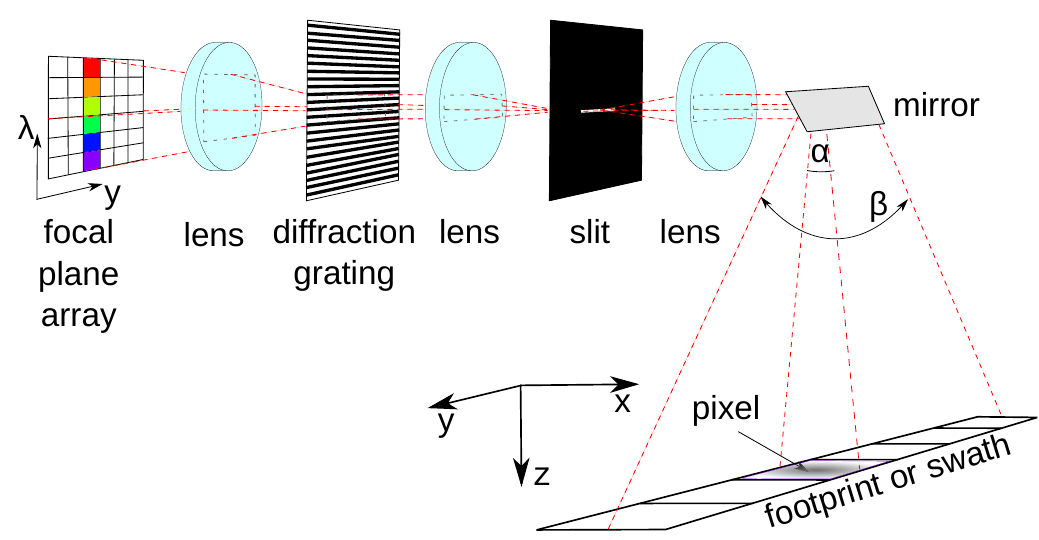
Figure 1: Working principle of a pushbroom sensor: The spectrum of the Gray shaded pixel is mapped to the coloured column on the focal plane array. Movement along the flight direction x allows formation of an image through combination of consecutive footprints. The field of view β determines the swath width while the instantaneous field of view α is related to the size of individual